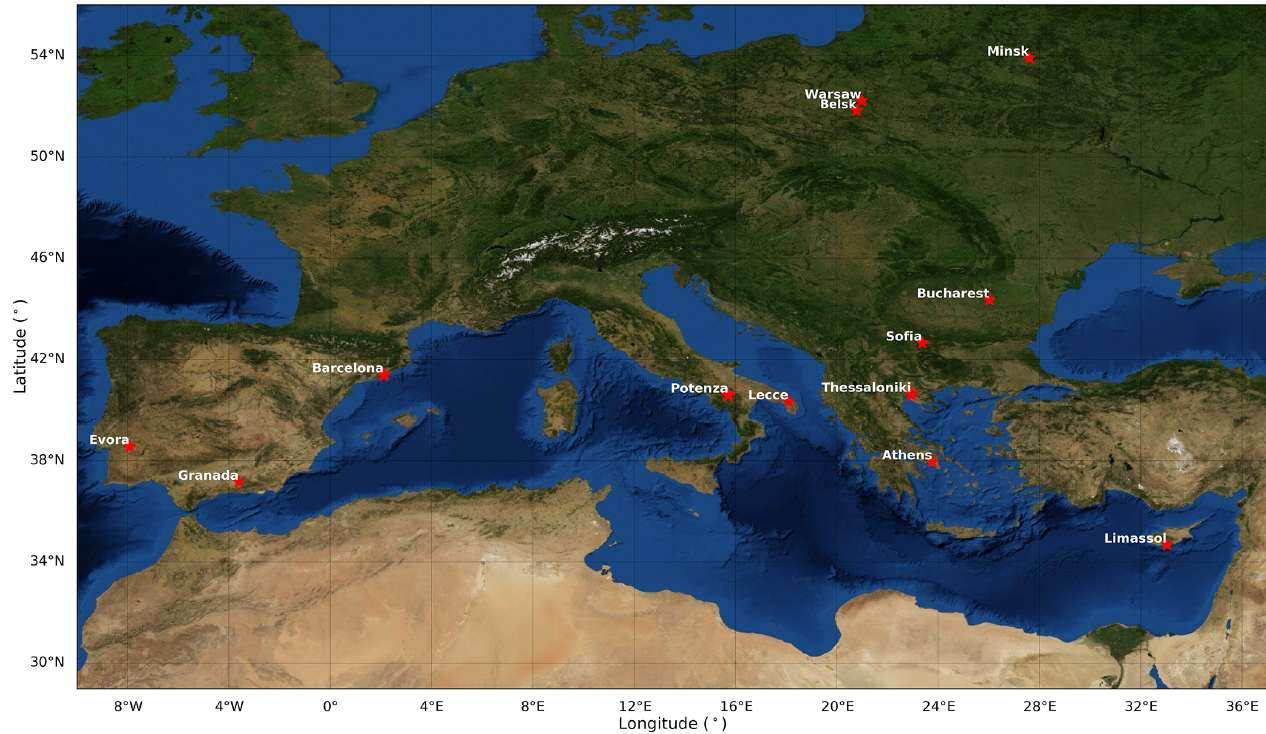
Figure 1. Geographical distribution of EARLINET lidar stations used in this